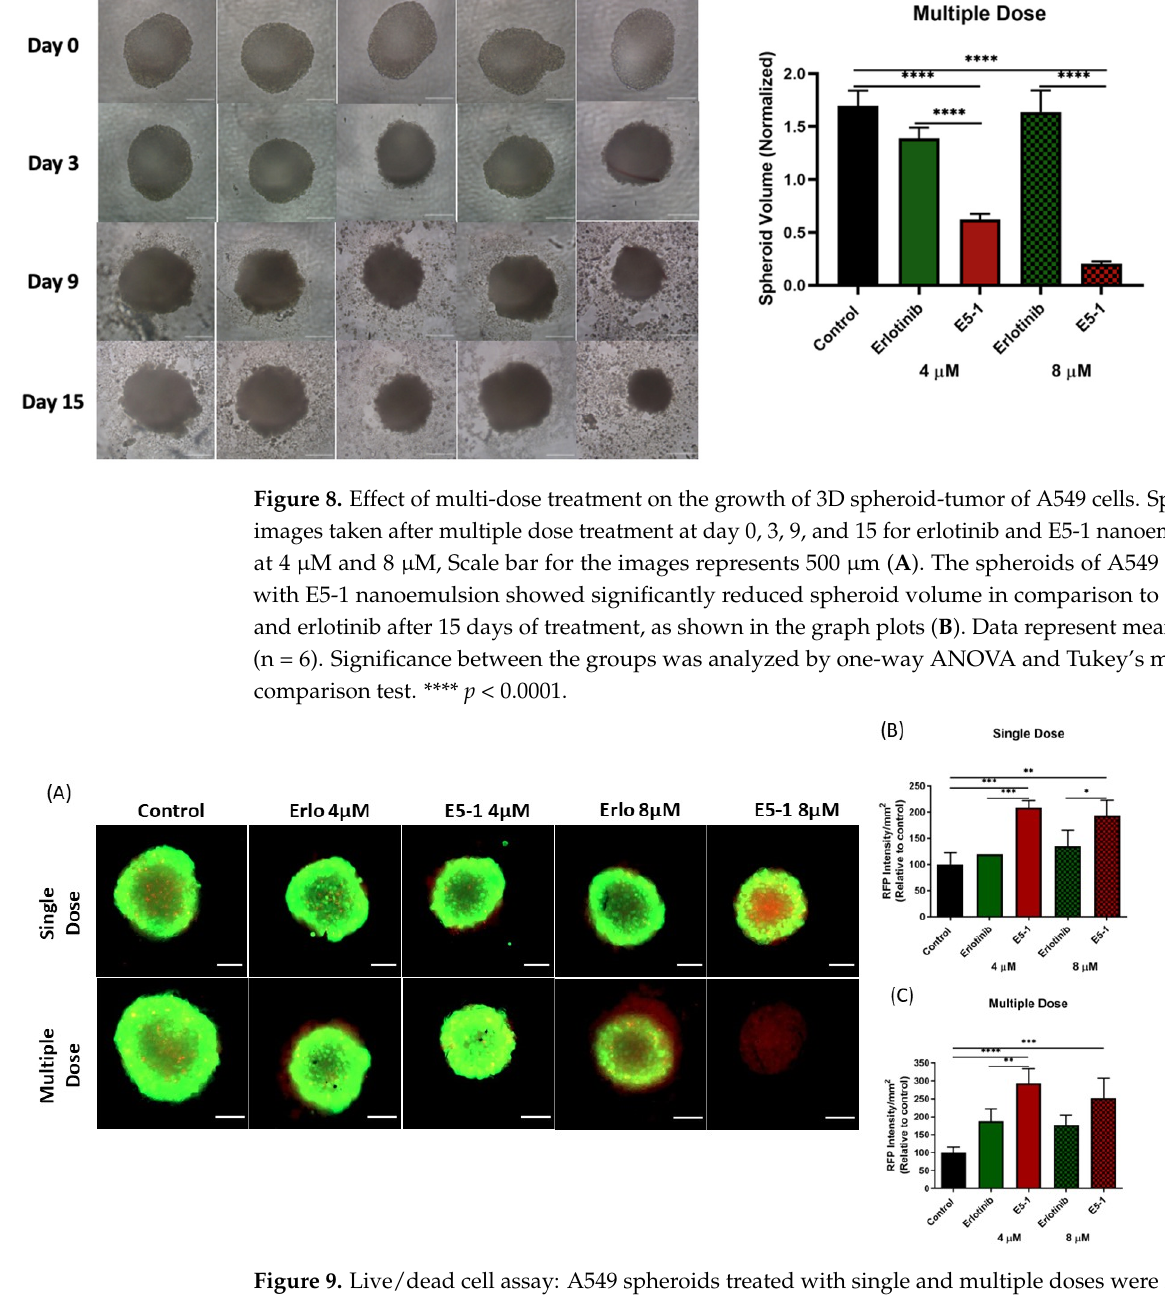
Figure 9. Live/dead cell assay: A549 spheroids treated with single and multiple doses were stained using the live/dead cell assay kit to determine the proportion of live and dead cells in the respective spheroids. Images were captured using an Evos-FL fl uorescence microscope with a 10× objective. Spheroid stained green for live cells and red for dead cells, Scale bar for the images represents 500 µm ( A ). The fl uorescent images were analyzed using ImageJ software and graphs were plo tt ed for red fl uorescence intensity signifying the proportion dead cells in the 3D spheroids for both groups, single dose ( B ) and multiple dose ( C ). Signi fi cance between the groups was analyzed by one-way ANOVA and Tukey’s multiple comparison test. Data represent mean ± SEM (n = 3). **** p < 0.0001, *** p < 0.001, ** p < 0.01, * p < 0.05 .